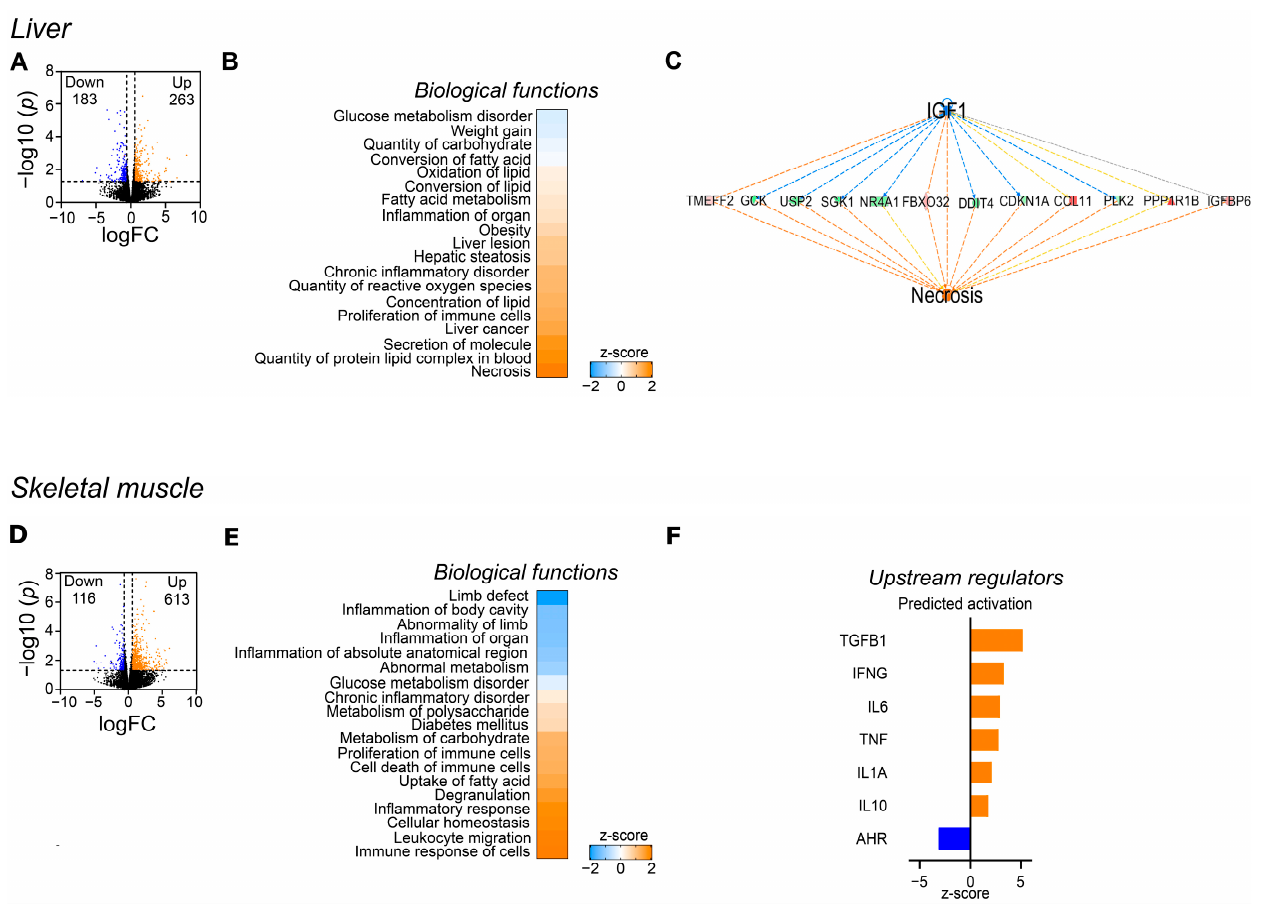
Figure 3. Effects of the WES diet on gene expression of liver and skeletal muscle at slaughter. Only CTR − and WES − animals were included in this analysis. ( A ) Volcano plot representing the RNAseq results in liver in WES − sows compared to CTR − sows. Orange dots indicate the differentially abundant transcripts (DATs) that are significantly up-regulated (cut-off of p < 0.05 and − 1.5 > fold change > +1.5), while the blue dots represent the down-regulated DATs (cut-off of p < 0.05 and − 1.5 > fold change > +1.5). ( B ) Heatmap representing the z-score of biological functions significantly affected by WES diet (calculation performed in IPA) in the liver. Blue indicates a negative z-score (inhibition) and orange a positive z-score (activation). ( C ) Regulatory effect of IGF-1 on the hepatic necrosis pathway. ( D ) Volcano plot representing the RNAseq results in skeletal muscle. Orange dots indicate the up-regulated DATs (cut-off of p < 0.05 and − 1.5 > fold change > +1.5), while the blue dots represent the down-regulated DATs (cut-off of p < 0.05 and − 1.5 > fold change > +1.5). ( E ) Heatmap representing the z-score of biological functions significantly affected by WES diet (calculation performed in IPA) in muscle. ( F ) Predicted activation of upstream regulators in skeletal muscle of WES −